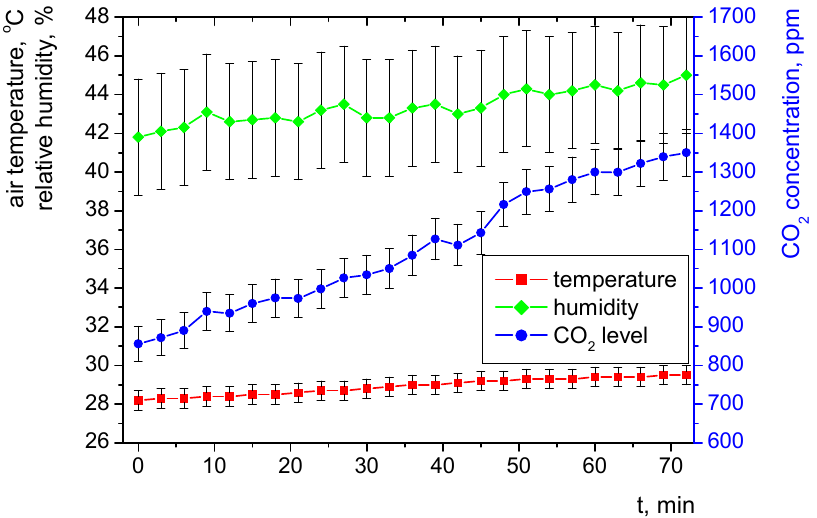
Figure 4. Example chances of air temperature, relative humidity and carbon dioxide concentration in a room of “A” building—together with measurement error bands.